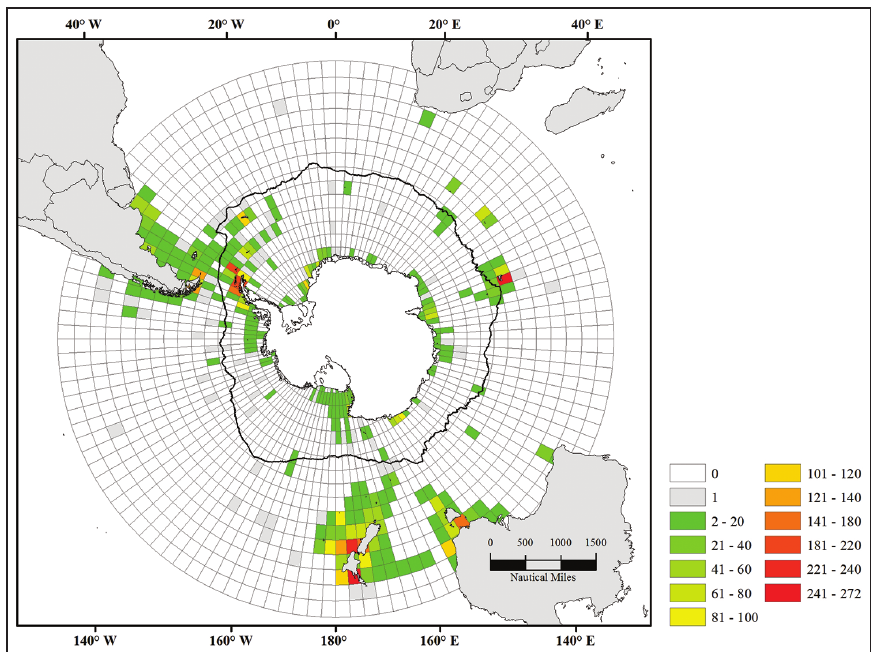
Figure 2b. Number of samples recorded per grid